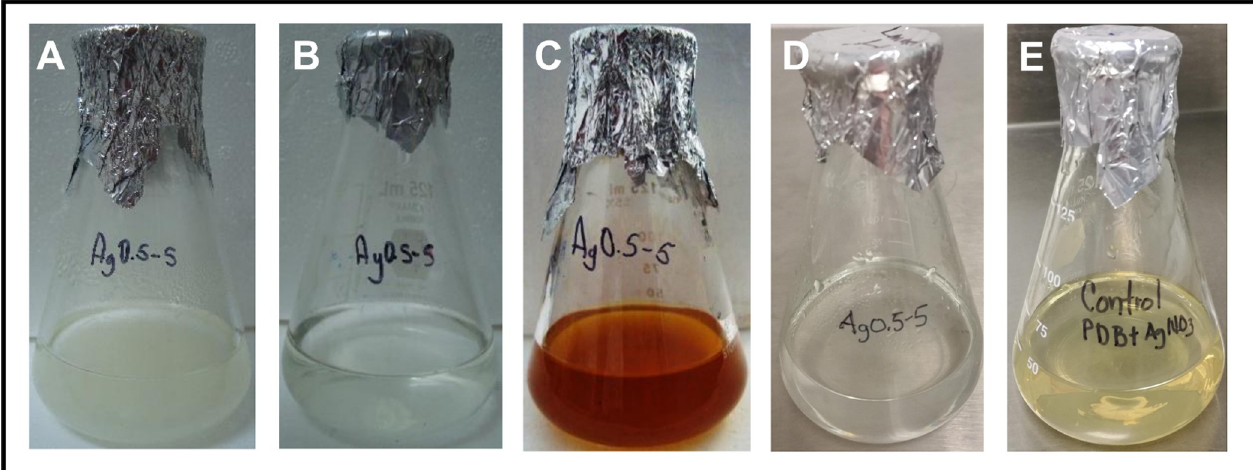
Fig 3. Extracellular synthesis of silver nanoparticles (AgNPs) by the Ag0.5–5 Fusarium scirpi strain. AgNPs were synthesized in water. (A) Fungal biomass incubated in sterile deionized water. (B) Free-cell water-filtrate. (C) Water-filtrate incubated with 1.0 mM of AgNO 3 during 7 days. (D) Water-filtrate incubated without AgNO 3 (control). (E) PDB culture media with 1.0 mM of AgNO 3 and incubated.